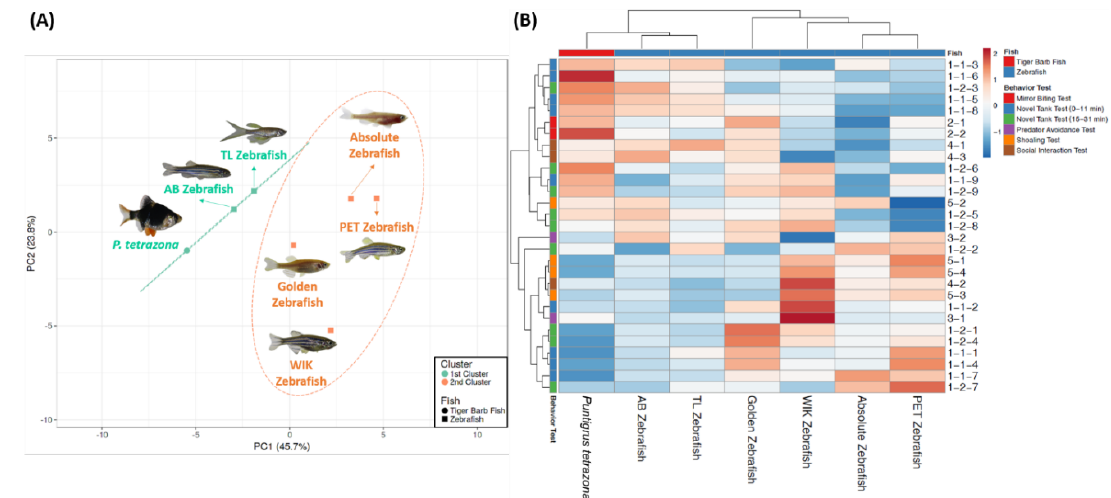
Figure 6. ( A ) Principal component analysis and ( B ) the hierarchical clustering analysis of the multiple behavior endpoints in several different strains of zebrafish. In Figure 6A, two major clusters from the hierarchical clustering analysis results were marked with the spring green (1st cluster) and orange (2nd cluster) circles (TL = Tübingen Long Fin, PET = Pet Store-purchased, WIK = Wild Indian Karyotype). In addition, the behavioral data from another fish species tiger barb ( Puntigrus tetrazona ) were also included as the outgroup, to conduct a deeper study about their behavior differences pattern.